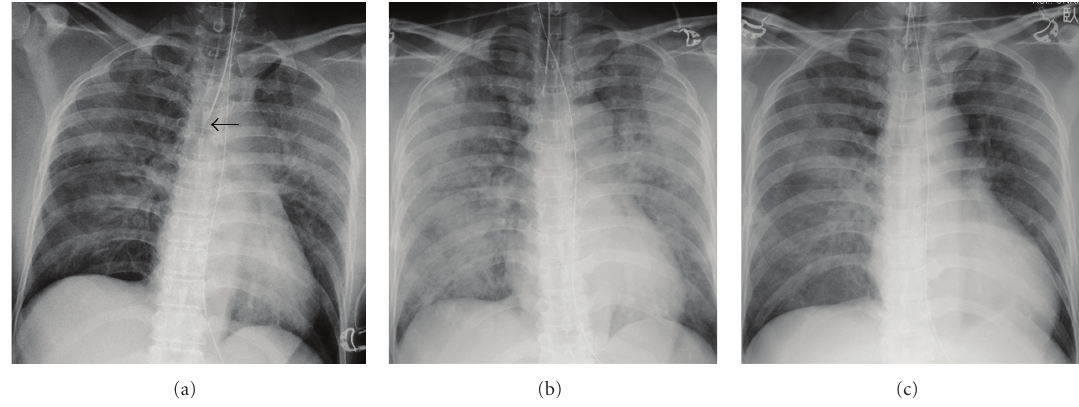
Figure 3: (a) A postoperative chest radiograph taken in the operating room showed bilateral di ff use ground glass attenuation. The central shadow was not widened: the cardiopulmonary rate was 48%. The tip of the intratracheal tube was located near the tracheal bifurcation (black arrow). (b) A chest radiograph demonstrated progression of the di ff use ground glass attenuation and appearance of alveolar consolidation. The photograph was taken in the intensive care unit 2 hours after surgery. (c) A chest radiograph revealed significant resolution of pulmonary abnormalities 3 days after the